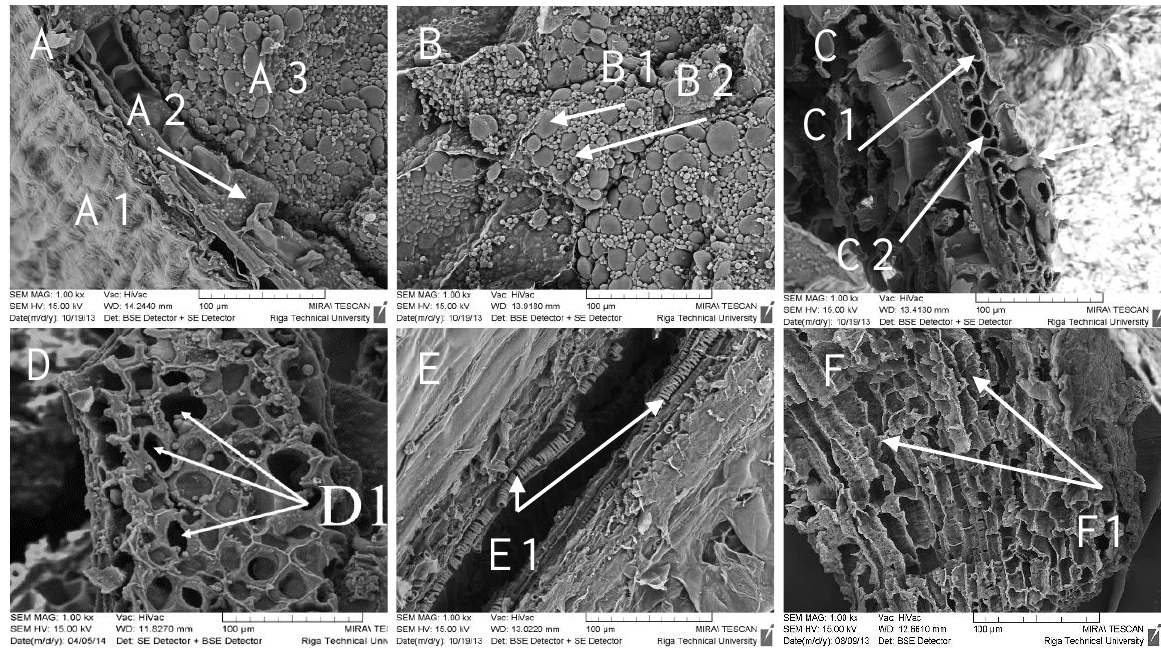
Figure 4. Micrographs from scanning electron microscope of the wheat grain ( A ) fractions: A1–Epidermis attached to aleurone layer A2 (proteins) and starchy endosperm A3 (starch); ( B) starchy endosperm composed of large B1 (15–35 µm) and small B2 (smaller than 10 µm) starch granules; ( C ) aleurone layer filled with protein tingly attached to inner pericarp composed of tube cells (C1) and cross cells (C2); ( D ) and ( F ) Wheat bran after 24 h hydrolysis with multi-enzyme complex Viscozyme ® L with obvious signs of epidermal cracking (D1) (holes size of 20–30 µ m); ( E ) Wheat bran after 4 h hydrolysis with multi-enzyme complex Viscozyme ® L with partially opened cellulose microfibers (E1); ( F ) Wheat bran after 24 h hydrolysis with multi-enzyme complex Viscozyme ® L with more tangible degradation of the epidermal layer